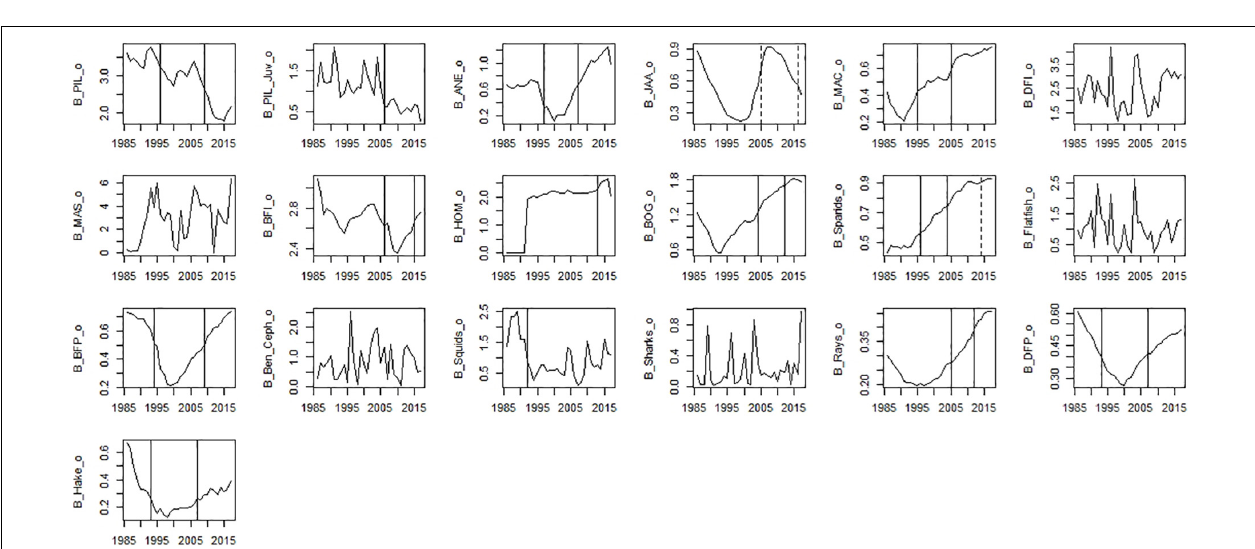
When performed on PC trends extracted from modelled biomass data group, STARS detected significant shifts in 1992 (for PC2_B_model), 2008 (for PC1_B_model), and 2015 (for PC1_B_model) while, CC showed discontinuity in the modelled biomass data in 1998 and 2013 ( Table 6 ).